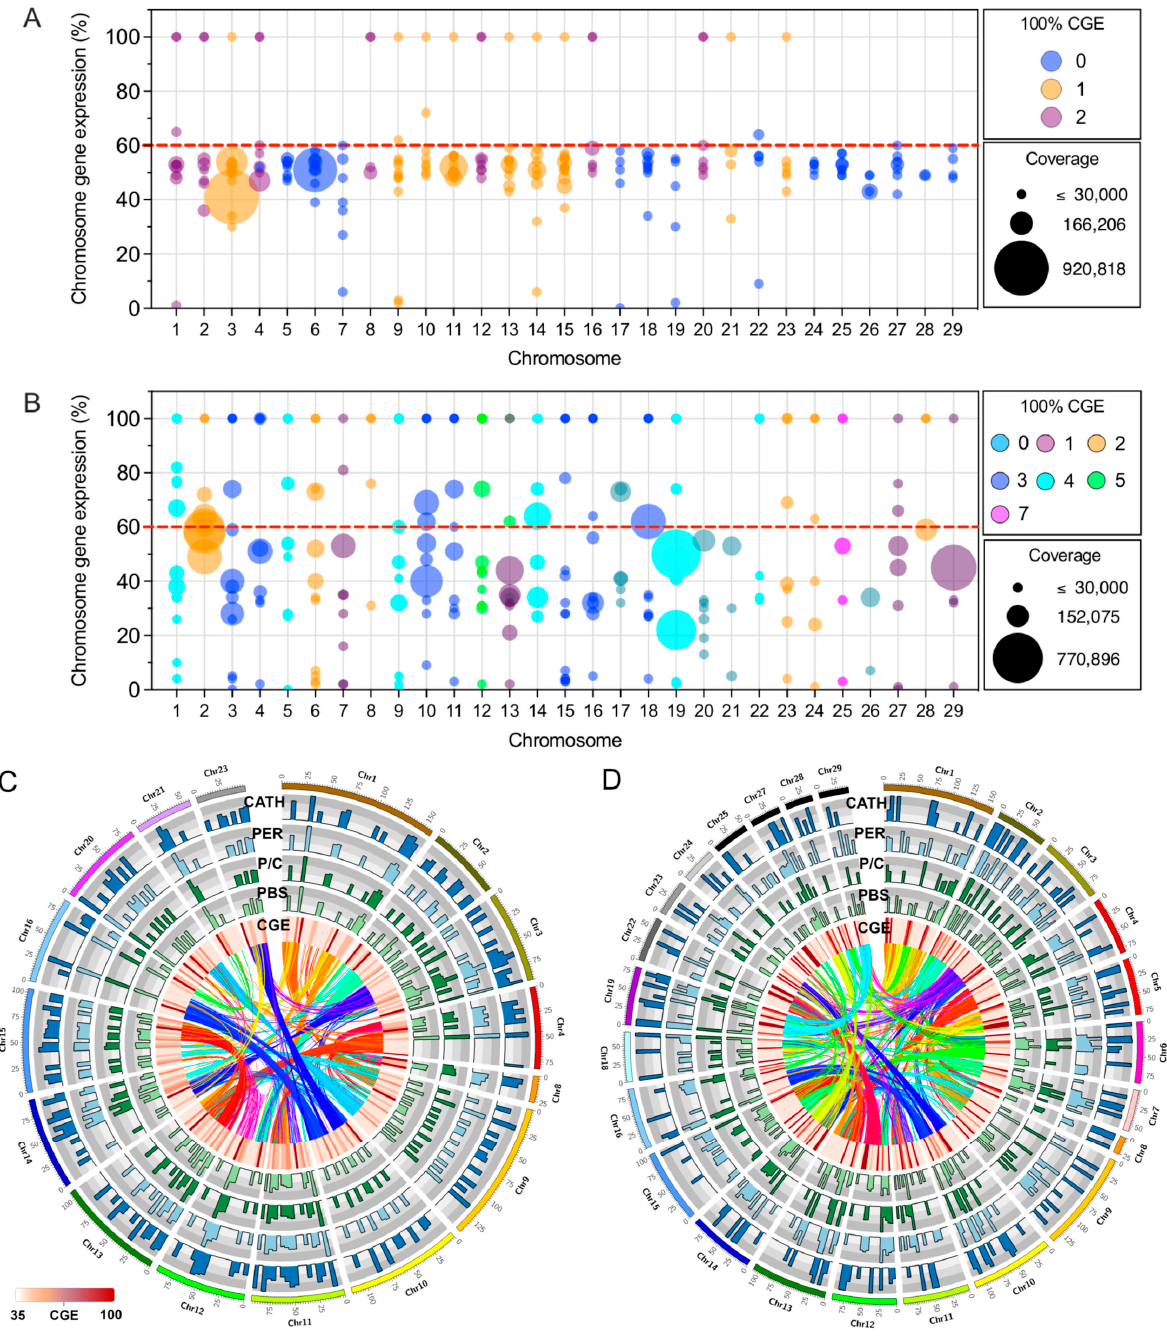
Figure 2. Whole-genome transcription in S. salar vaccinated with Peritrophin, Cathepsin, a combi- nation of P/C, and PBS. The bubble plot shows the expression threshold analysis in vaccinated S. salar head kidney ( A ) and skin ( B ). The circle sizes represent chromosome coverage. Colored circles represent how many times 100% CGE is reached per chromosome. Atlantic salmon chromosome regions with CGE index variation > 60 in the head kidney ( C ) and skin ( D ). Histograms show the coverage of transcripts from different regions of the chromosomes. The heatmap in red represents the CGE index, which showed the expression variation among the four experimental groups. Syntenic blocks among S. salar chromosomes are also